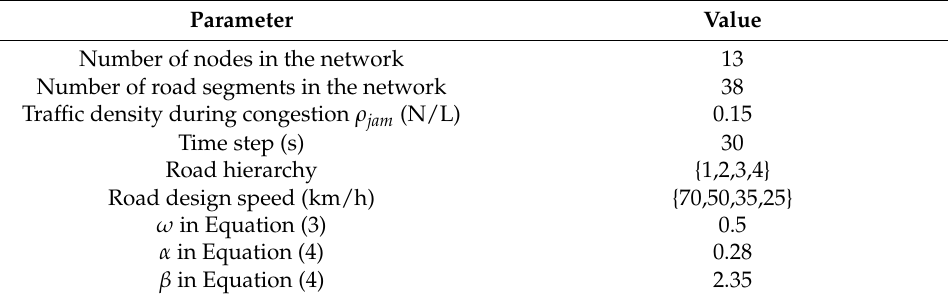
Figure 4. Nguyen network and parameters. Table 1. Parameter settings of the simulation